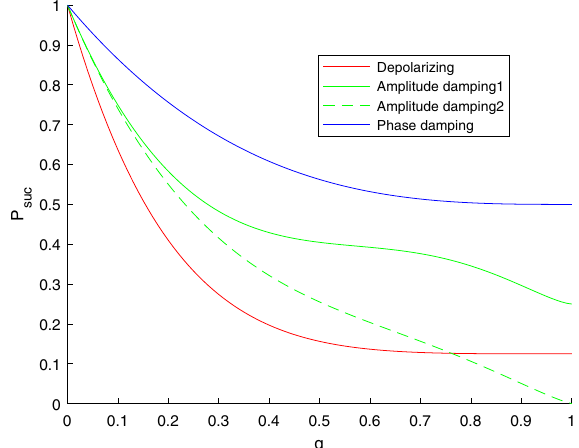
Figure 3. The variations of the success probabilities P suc on the depolarizing, amplitude damping, and phase damping channels with noise strength